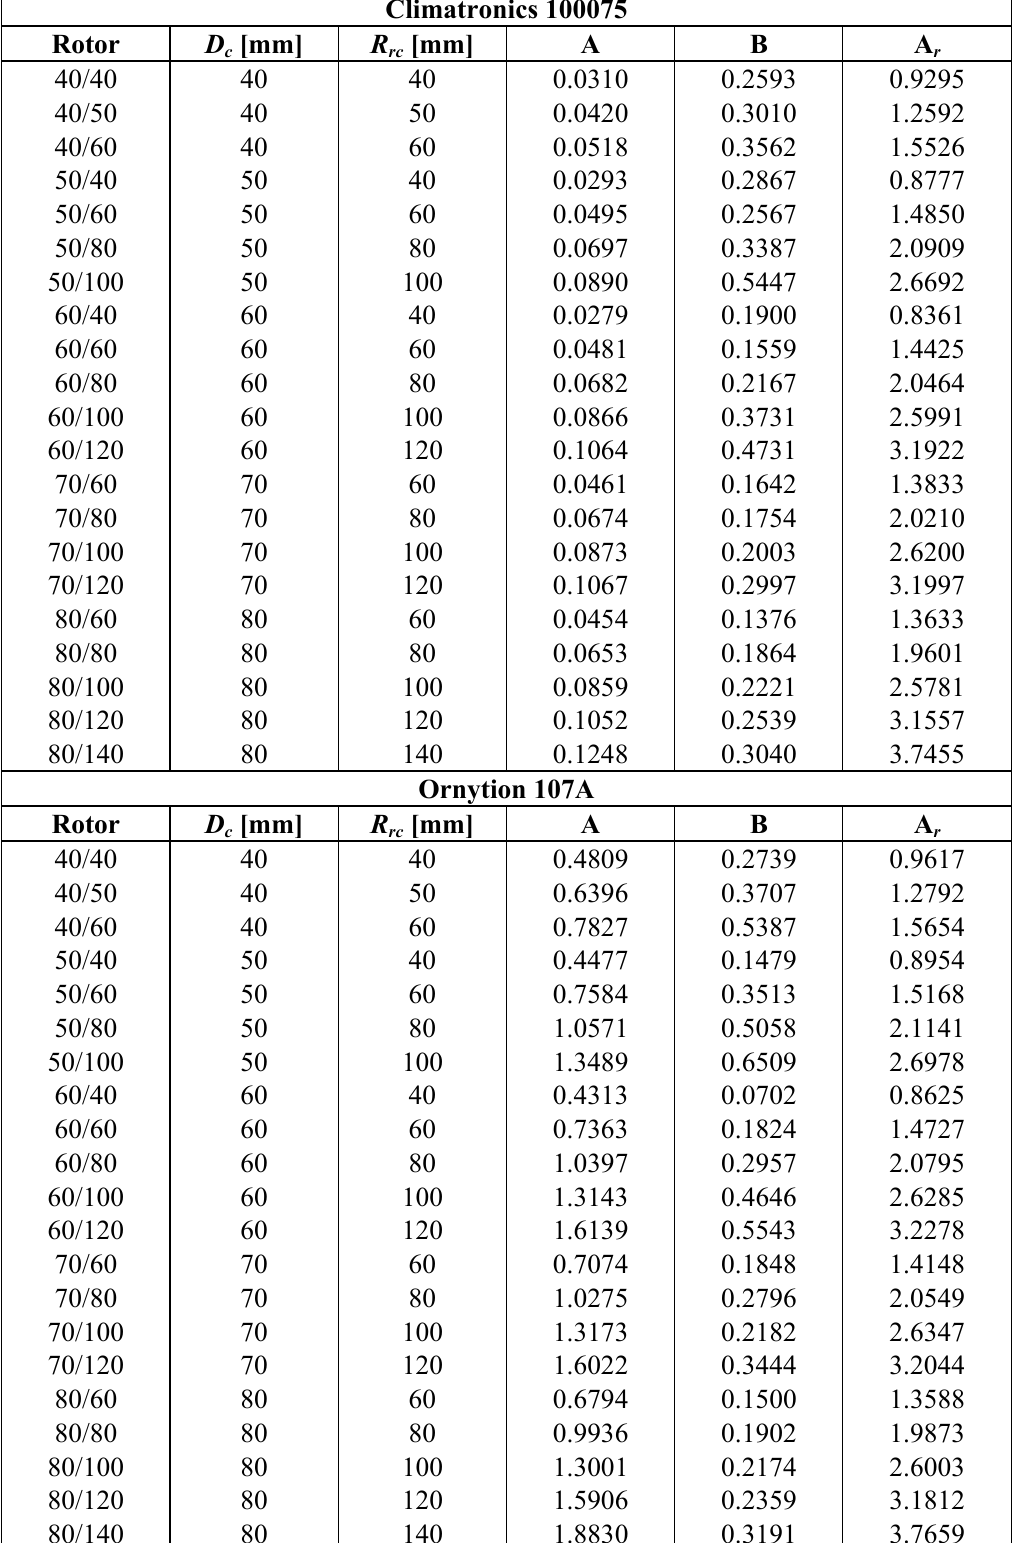
Table 1. Results of the calibration performed on the Climatronics 100075 and Ornytion 107A anemometers. The calibration constants, A, B and A , and the cups’ center rotation radius, R cups’ diameter, D c rotor